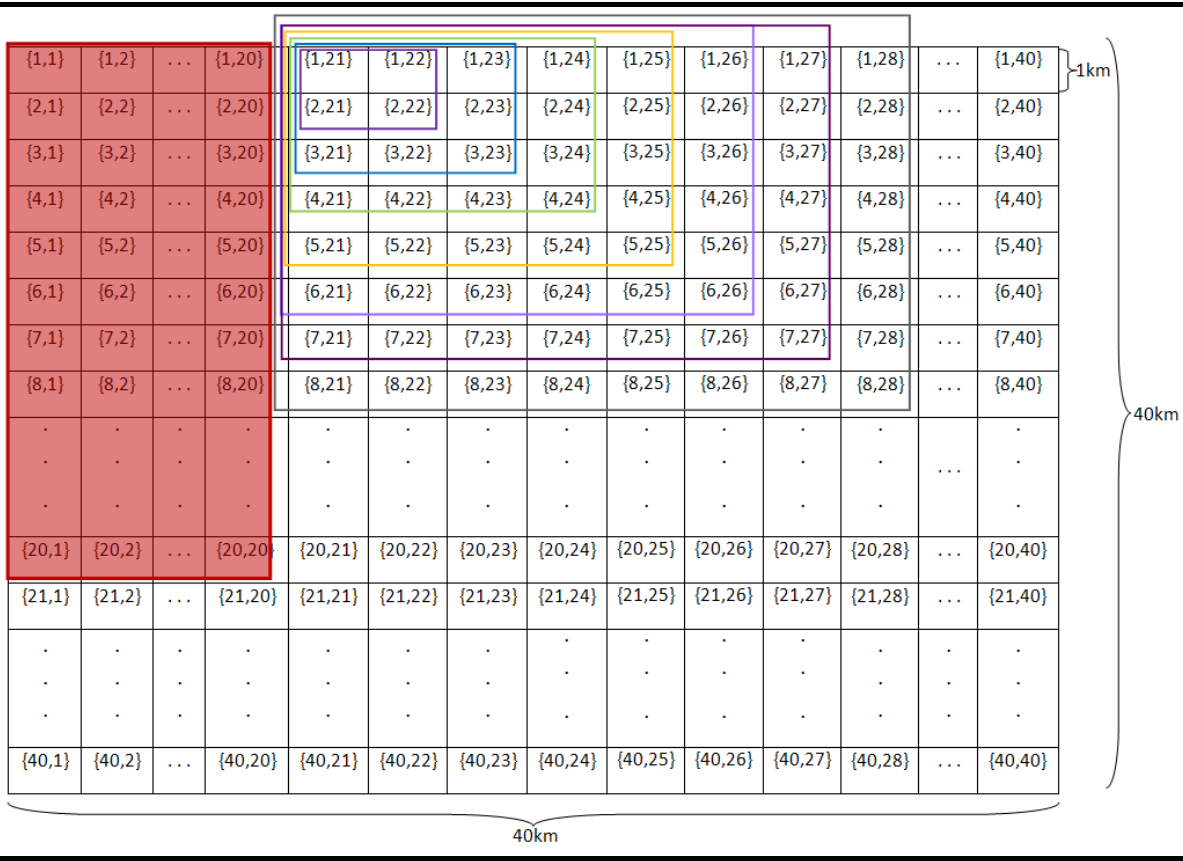
Figure 3 . Sub-grid size and ANN determination using data on 7th November 2005. The red-filled data were used for training. The sub-grid sizes used are shown with unfilled